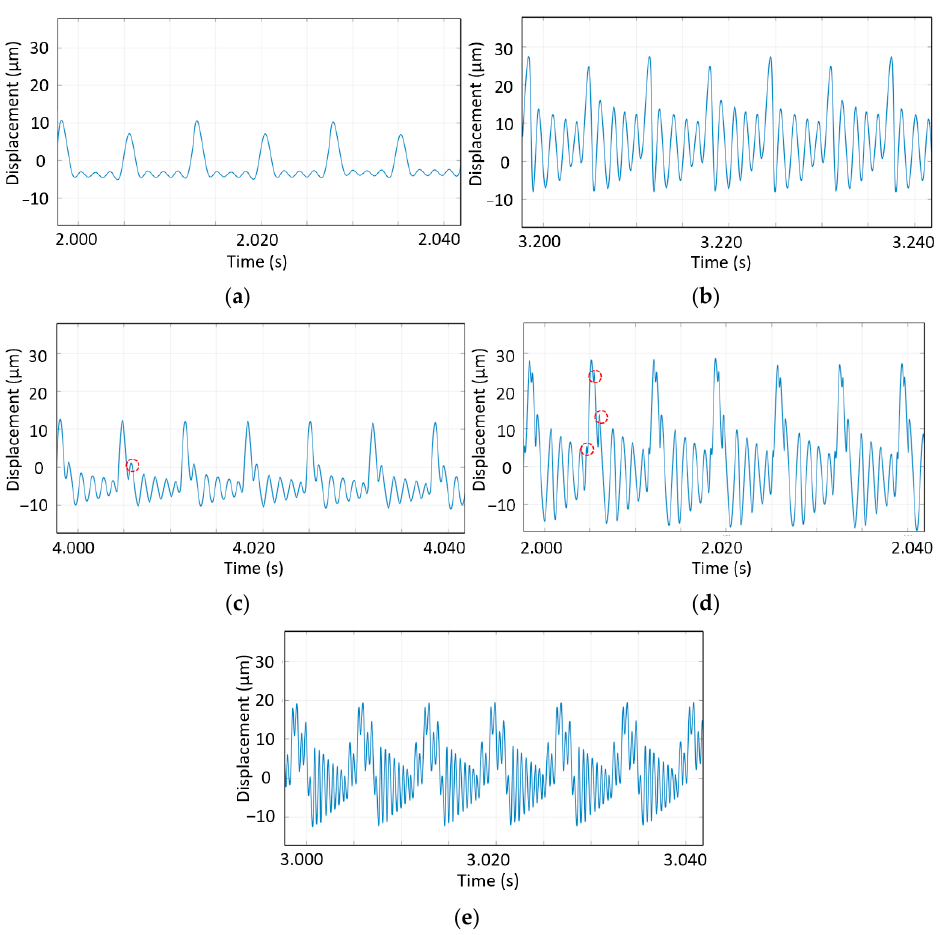
Figure 22. Chatter vibration for ( a ) sample 3, ( b ) sample 5, ( c ) sample 6, and ( d , e ) sample 7 (red circles indicate peaks caused by chatter).